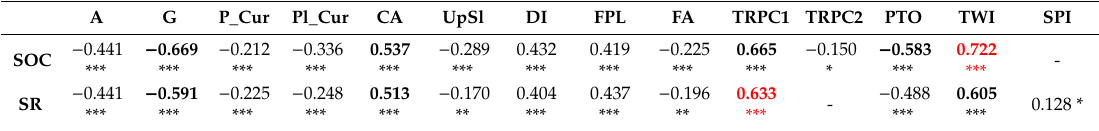
Table 3. Topographic impacts on soil organic carbon (SOC) and soil redistribution (SR)